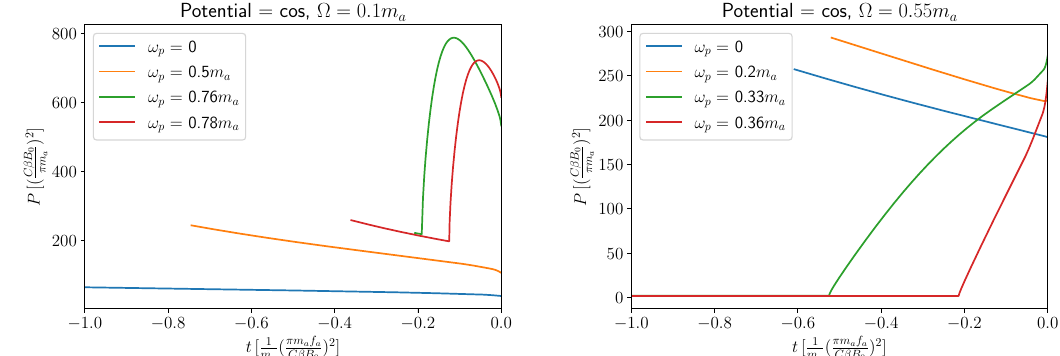
Figure 7 . Power radiated as a function of time for the cos-potential for a few different values of the external magnetic field frequency Ω and the plasma frequency ω p . We have defined t = 0 to be the time at which ω ( t = 0) = ω crit , where ω crit is given by (5.2).